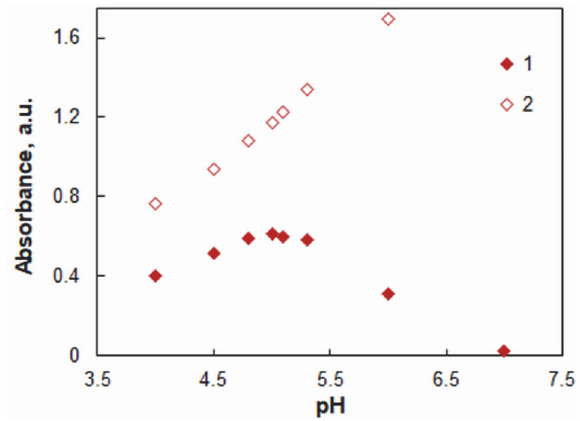
Figure 2. Absorbance of the V V – TAO – A336 complex (1) and the blank (2) vs. pH of the aqueous phase. c V = 2 × 10 −5 mol dm −3 , c TAO